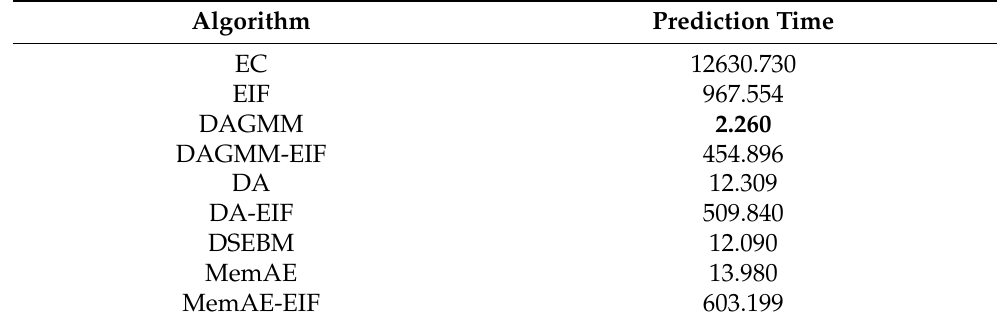
Table 6. Prediction times to analyze 1000 records from the CIC-IDS2017 dataset. Times shown in the table are measured in